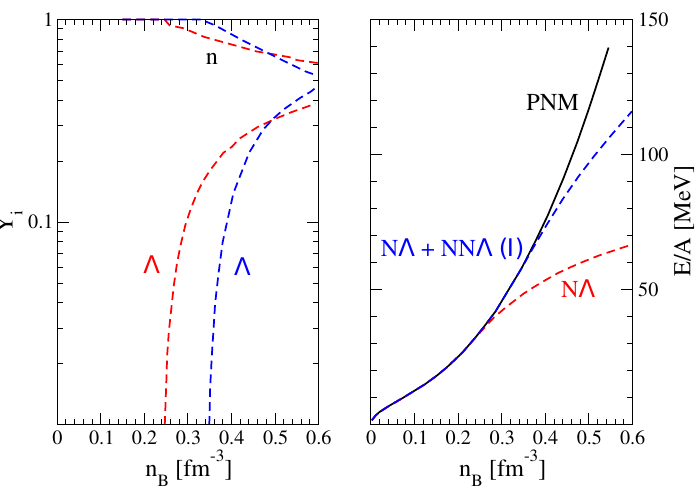
Figure 4. Neutron star matter compositions ( left panel ) and corresponding EOSs ( right panel ) as a function of the baryonic density, for the AFDMC calculations proposed (adapt from Ref. [215]). See text for details.